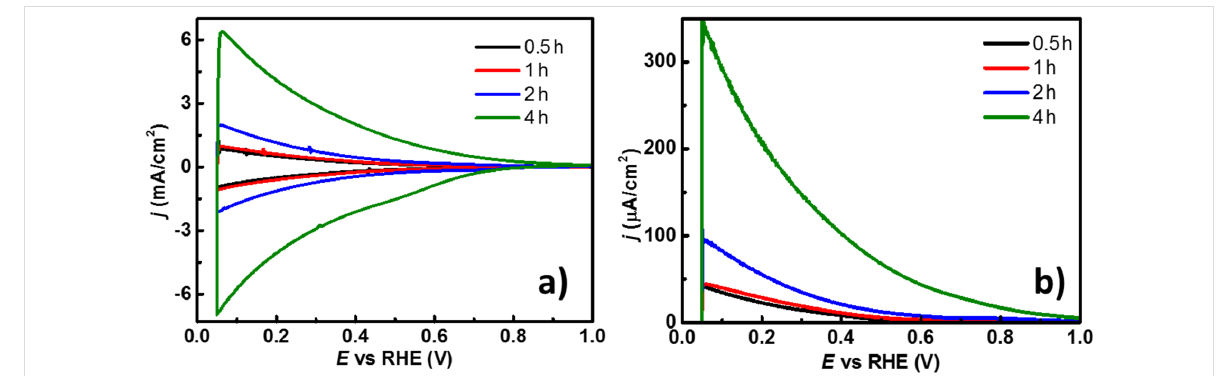
Figure 5: (a) Cyclic voltammograms (CV) at v = 50 mV/s; and (b) linear-sweep voltammograms (LSV) at v = 5 mV/s in the anodic direction for the TNTs grown at different t a , in 0.5 M H 2 SO 4 , in darkness in N 2 -saturated electrolyte.